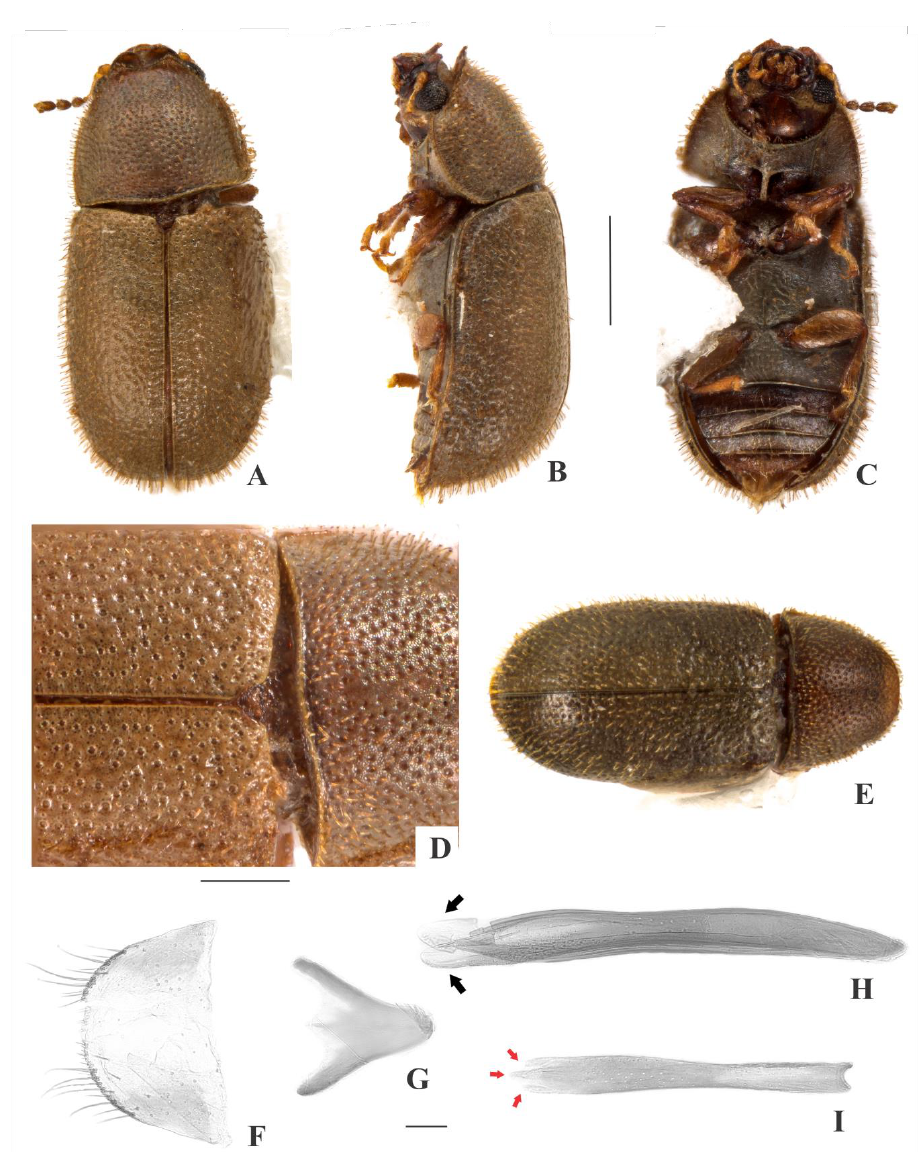
Figure 1. Cis bicaesariatus sp. n. , male holotype ( A – D ), female paratype ( E ), aedeagus of holotype ( F – I ): A. Dorsal view. B. Lateral view. C. Ventral view. D. Scutellar shield and part of the pronotum and elytra. F. Sternite VIII. G. Basal piece. H. Tegmen, note bilobed apex (black arrows). I. Penis, note acute angulatios at apex (red arrows). Scale bars: 0.5 mm ( A – C , E ), 0.2 mm ( D ), 0.05 mm ( F–I ).